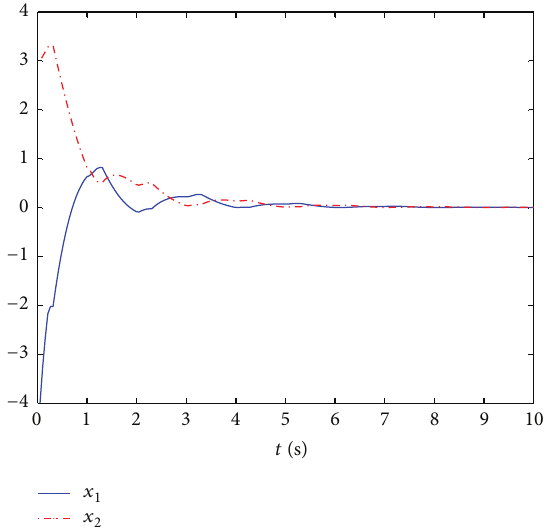
Figure 2: State-response of the overall closed-loop